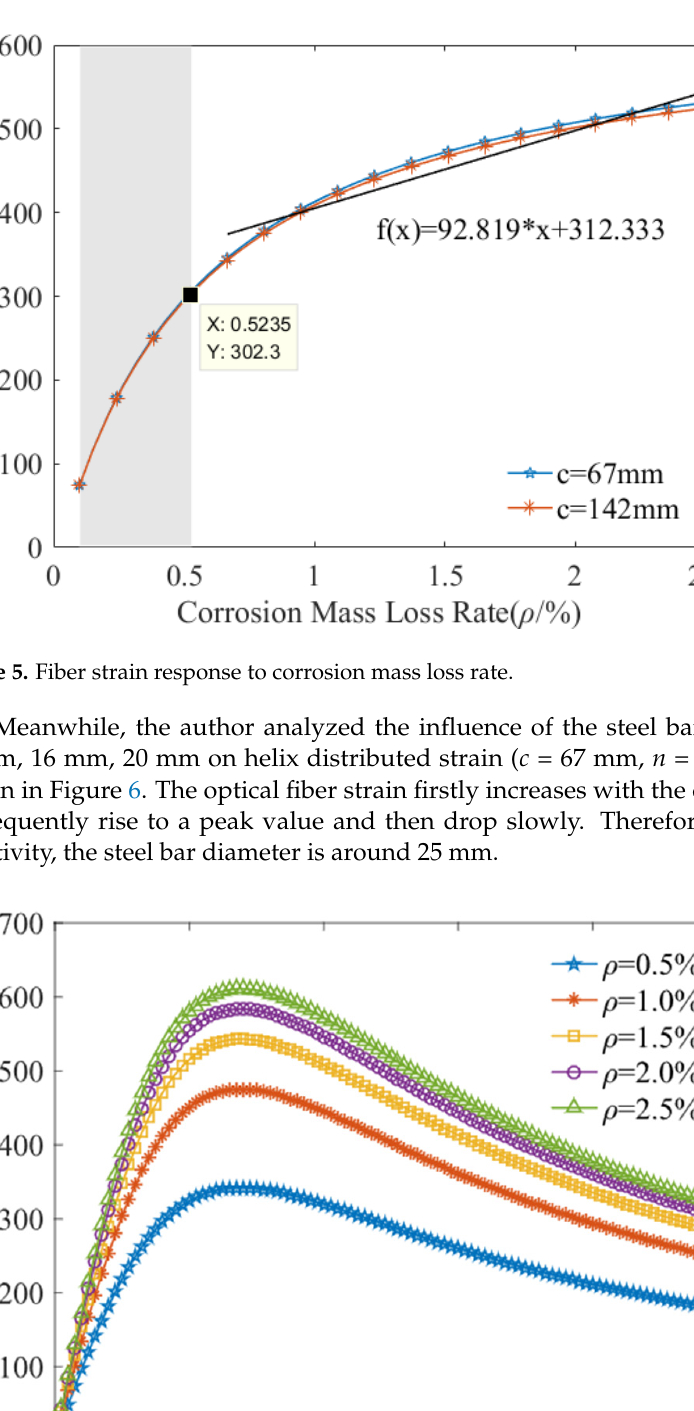
Figure 4. Fiber strain response with protective layer thickness.